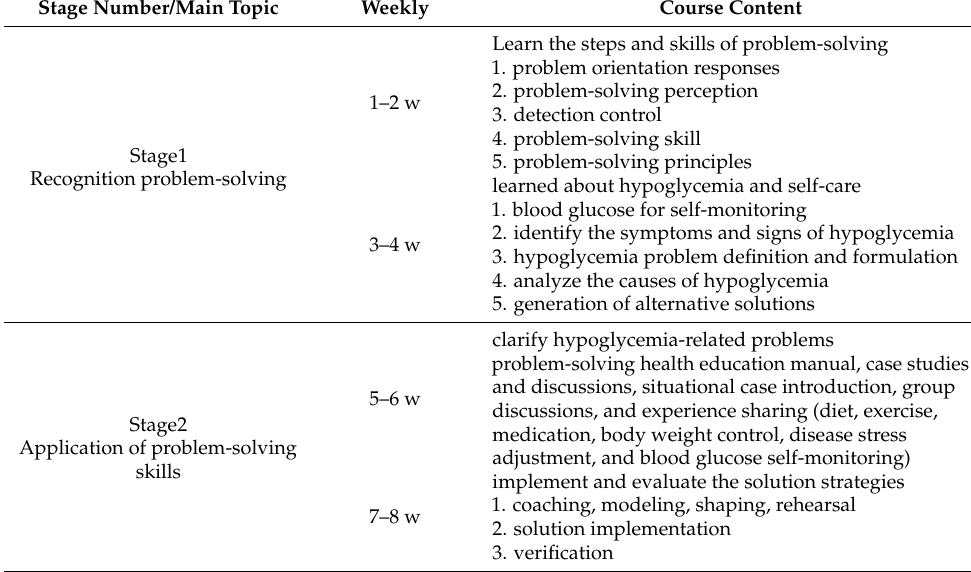
Table 1. Course Schedule for the